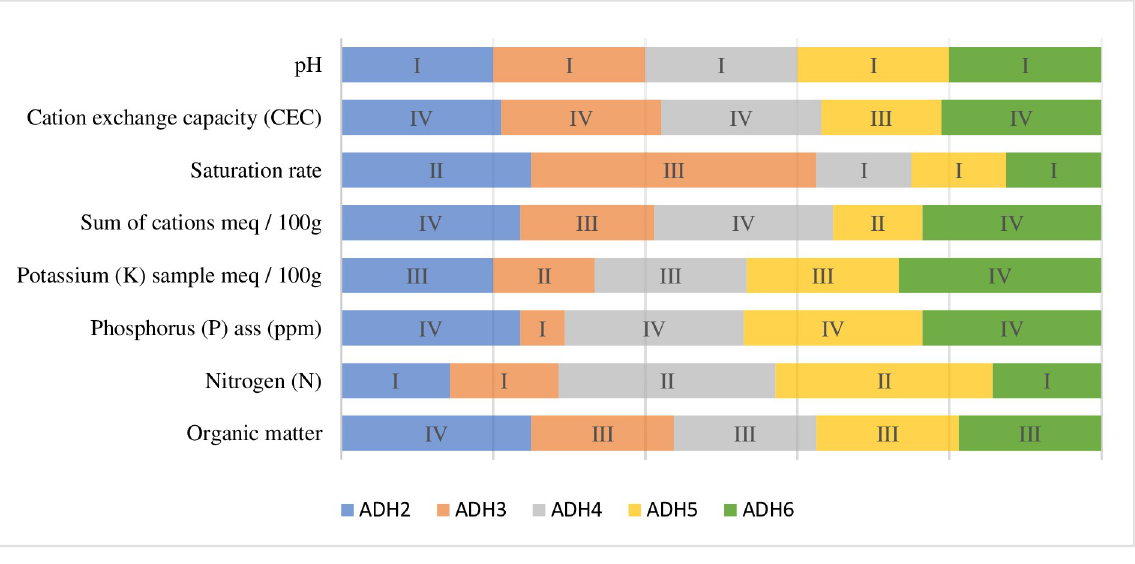
Fig 3. Degree of intensity of associated limitations, according to